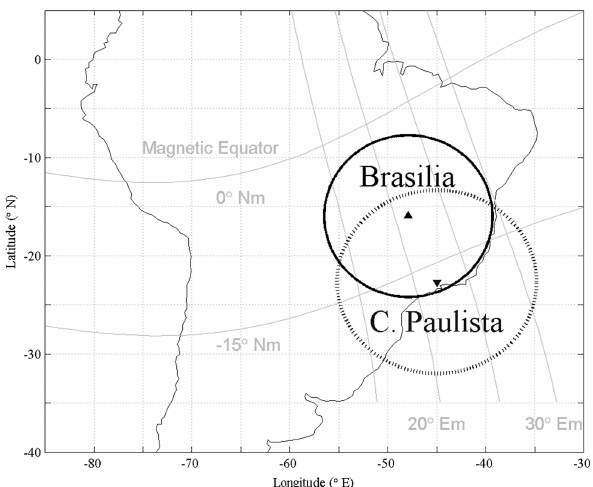
Fig. 1. The view area and encompassed coverage of the photome- ter at Cachoeira Paulista (dashed circle) and the GPS receiver at Brasilia (solid circle) superposed on the map of South America. The imager covers a zenith angle range of about 80 ◦ , while the receiver collects signals for the elevation angle greater than 15 ◦ .